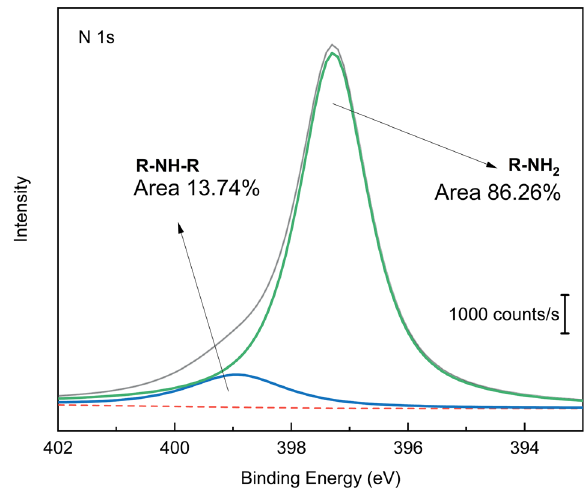
Fig. 5 Binding energies of secondary amine (R-NH-R) and primary amine (R-NH2) bonds of chitosan fi lm applied on the glutaraldehyde linked-PDA fi lms